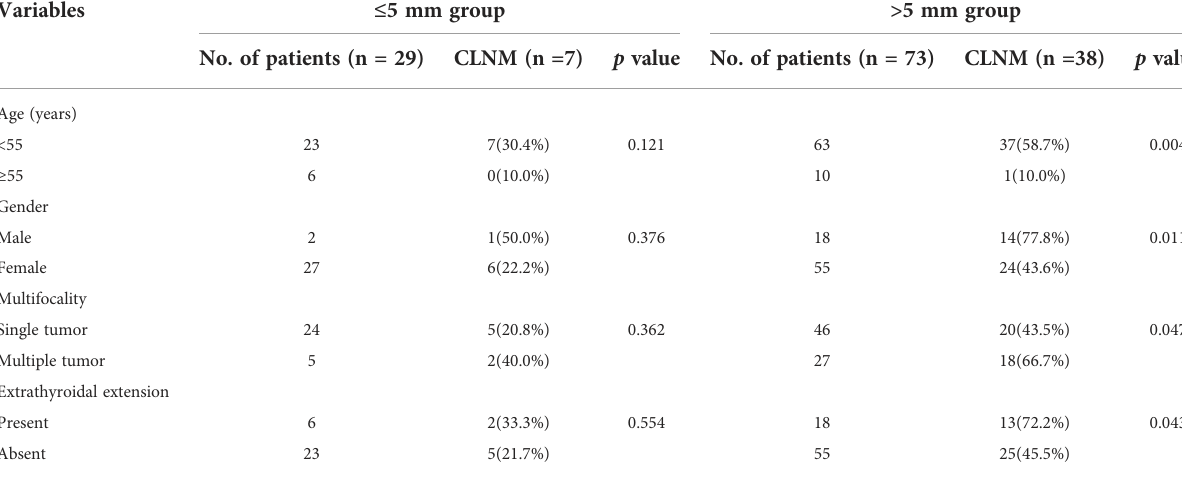
TABLE 2 Clinicopathologic factors related to central lymph node metastasis in >5 mm and ≤ 5 mm